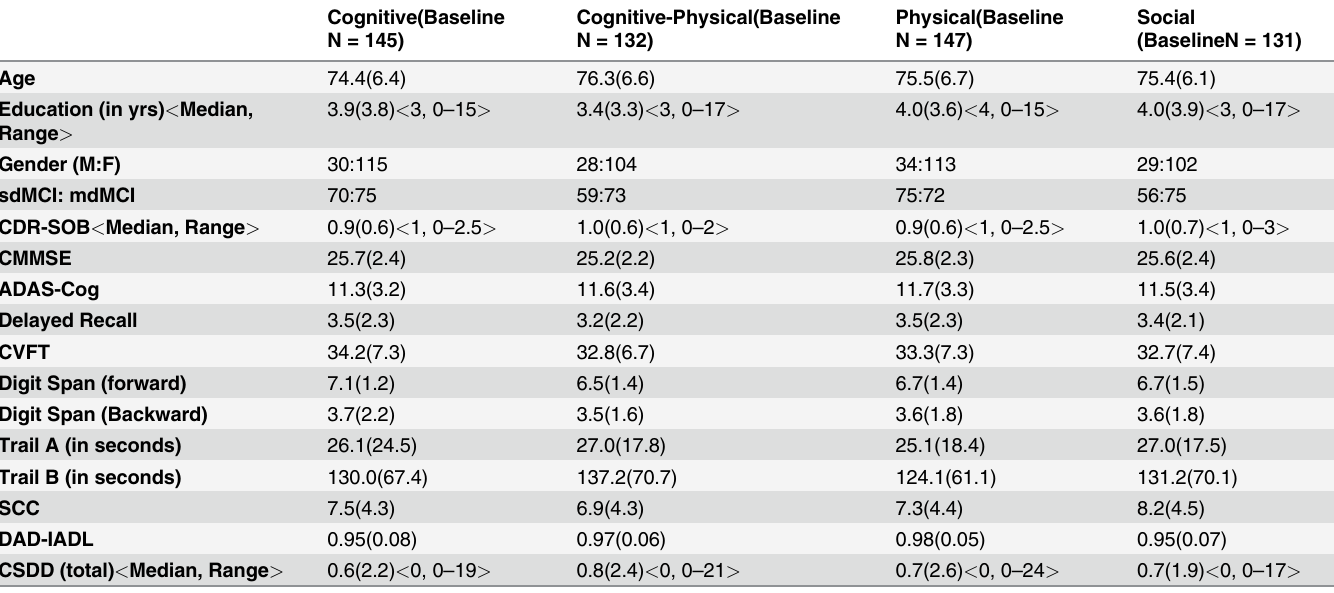
Table 1. Baseline demographic and cognitive characteristics of intervention groups.